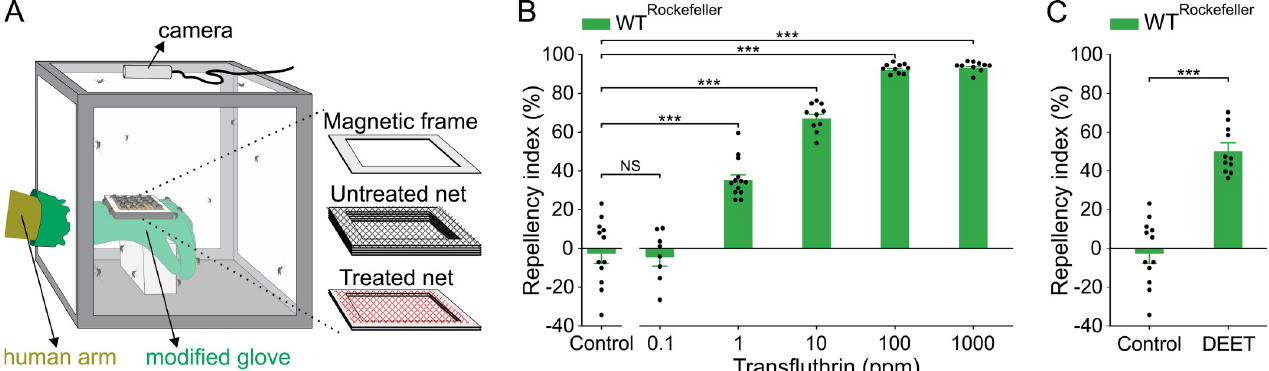
Fig 1. Transfluthrin elicits spatial repellency in Ae . aegypti . (A) A schematic drawing of the hand-in-cage setup. (B) Dose-dependence of transfluthrin repellency in Rockefeller; Student’s t -test, t = 0.25, df = 18, P = 0.802 for 0.1 ppm, Mann-Whitney Rank Sum test, U = 0, P < 0.001 for both 1, 10, 100 and 1000 ppm; NS = not significant, ��� P < 0.001; n values for: control = 12, 0.1 ppm = 8, 1 ppm = 13, and the rest = 10. (C) Repellency by DEET (1 ppm) in Rockefeller; Student’s t -test, t = 8.45, df = 21, P < 0.001; ��� P < 0.001; n values for: control = 12 and DEET = 11. The control represents the baseline activity in response to the solvent. Data are presented as mean ± SEM. Dots over the bars represent individual replicate values.